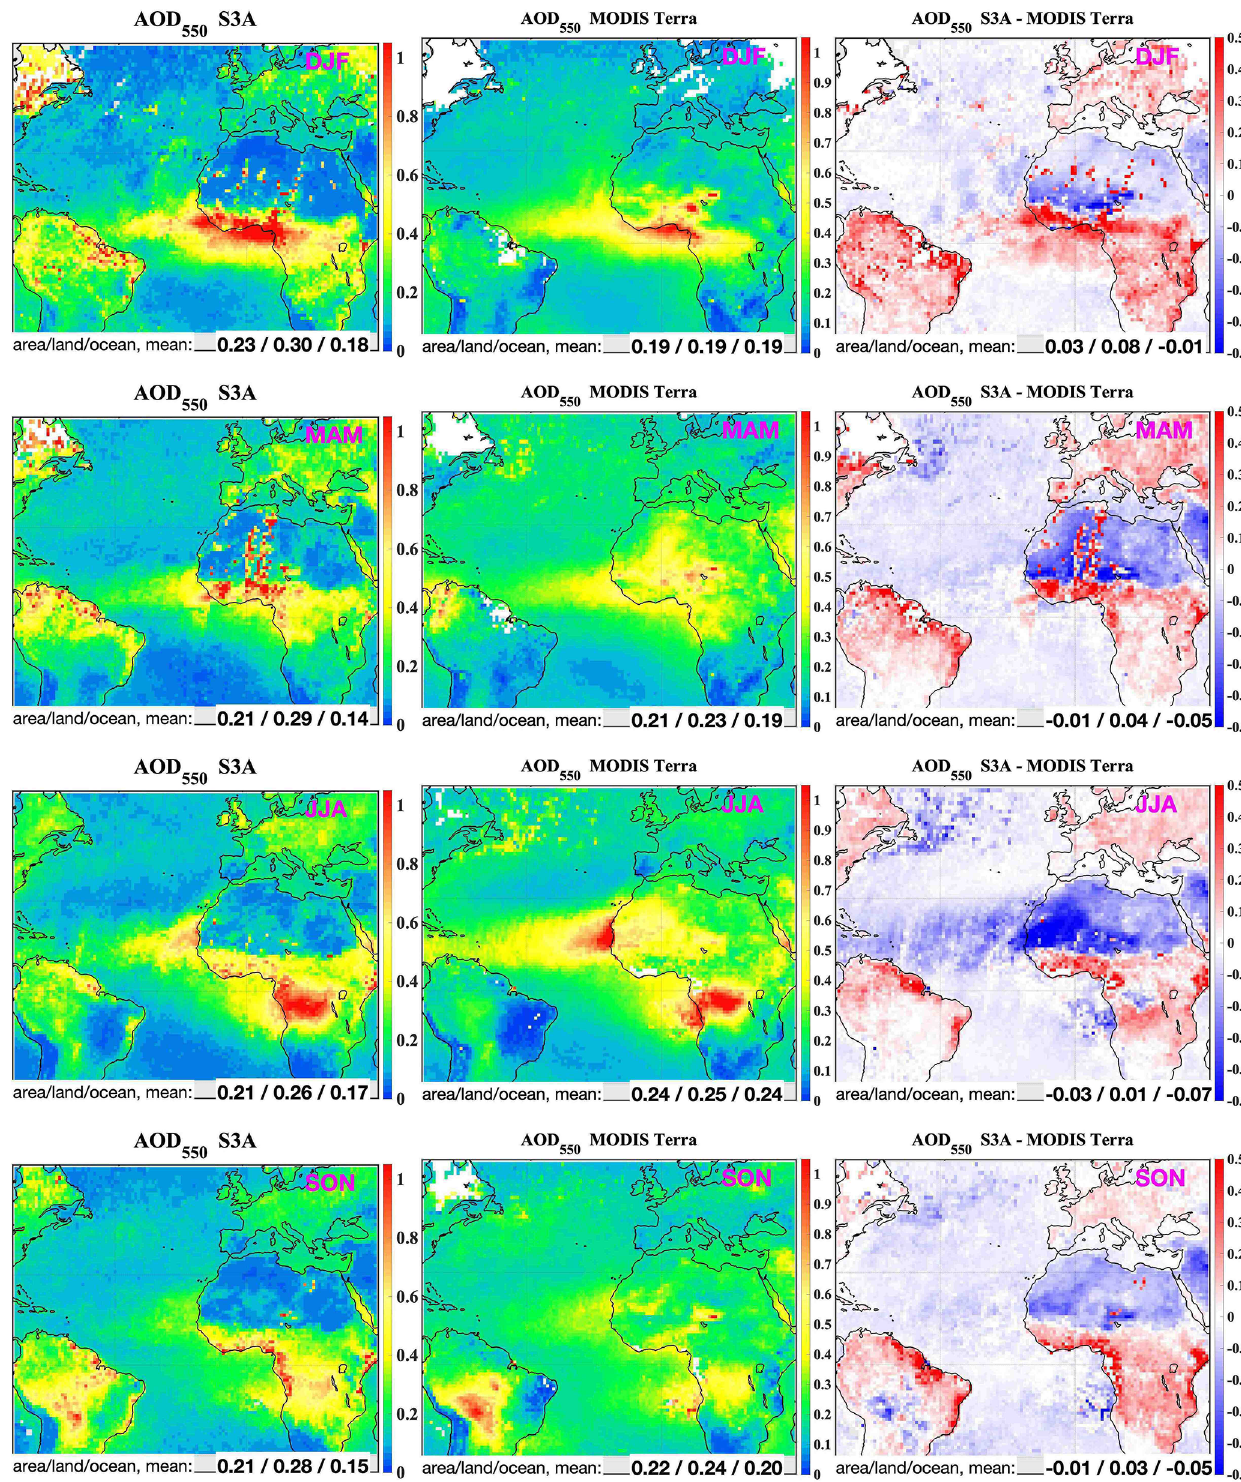
Figure 31. Seasonal (top down: DJF, MAM, JJA, SON) S3A (left panel), MODIS Terra (middle panel) AOD 550 , and the difference in AOD 550 between S3A and MODIS Terra (right panel); from monthly aggregates created from collocated daily S3A and MODIS Terra AOD